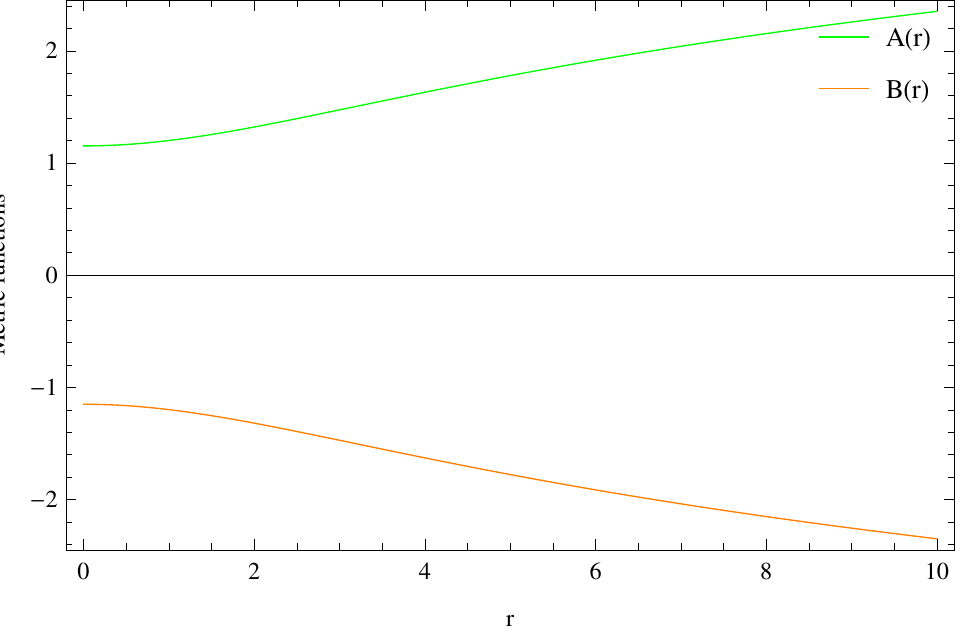
Figure 11. The metric functions are plotted against the radial parameter r for the values of constants ω = − 1, C 4 = 0.001, C 5 =